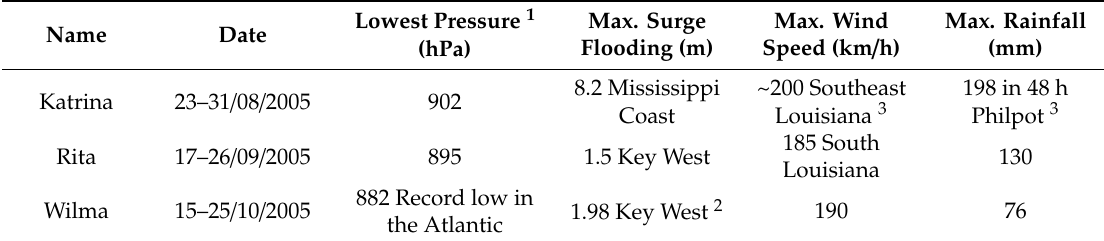
Table 1. Main characteristics of Katrina, Rita and Wilma Hurricanes that hit the coasts of Florida and